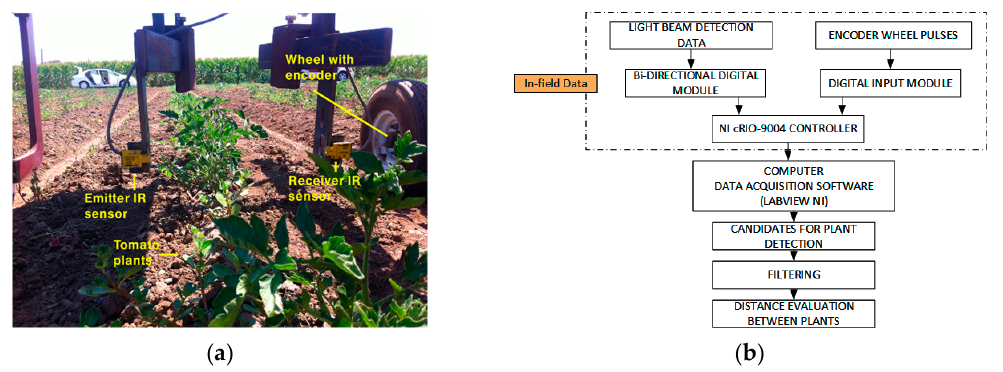
Figure 2. ( a ) Light-beam sensors mounted on the experimental platform designed for field trials at UC Davis, California; ( b ) Progressive monitoring flowchart using light-beam